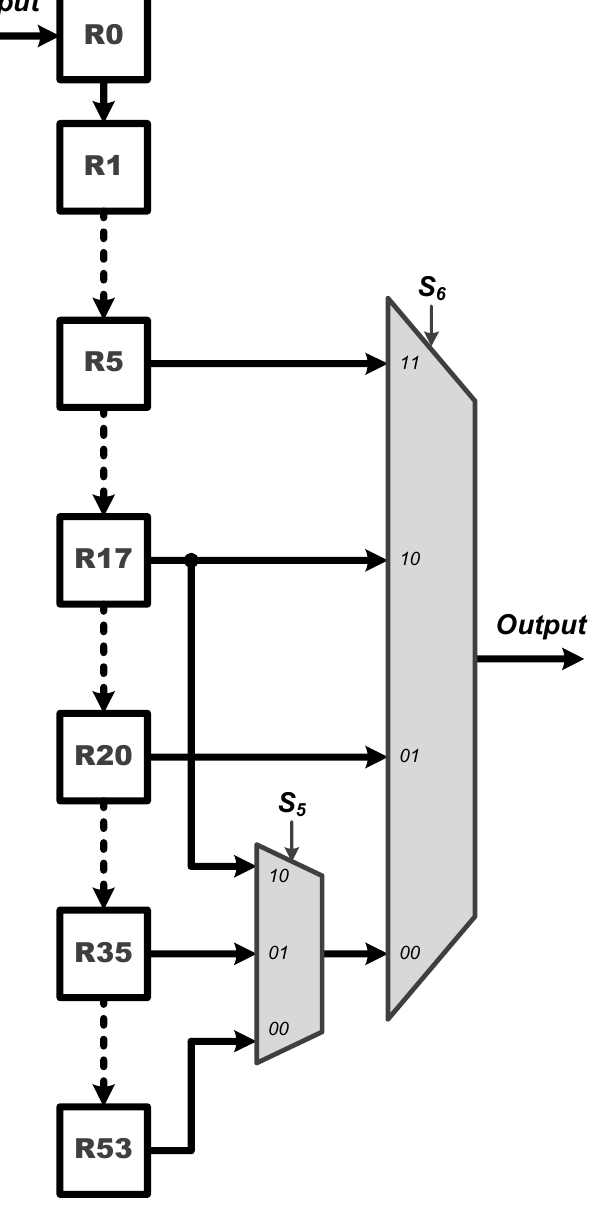
Figure 6. Architecture of the proposed Control Buffer module.